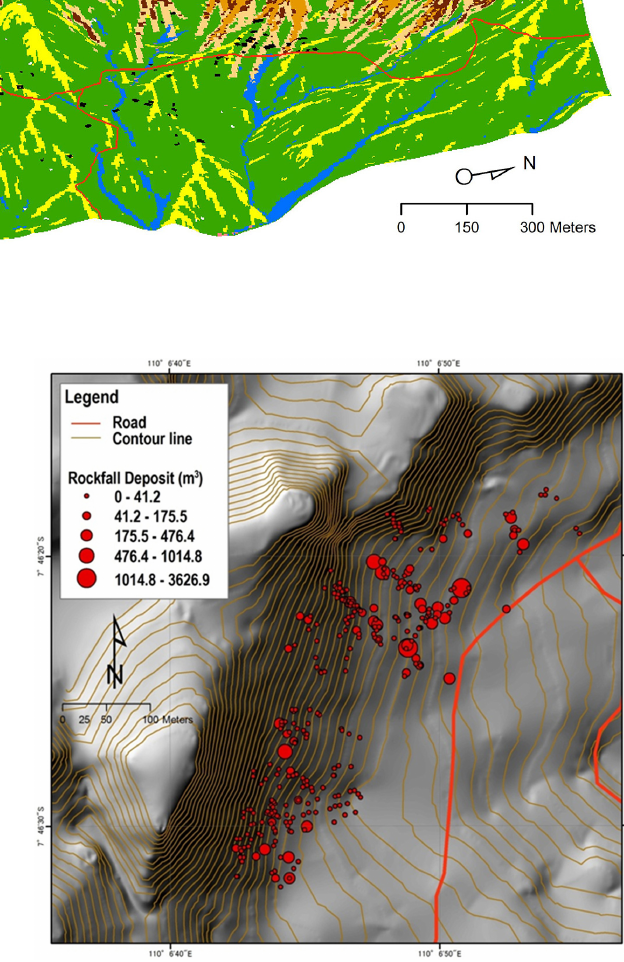
Figure 4. Distribution of rockfall boulders in Gunung Kelir ob- tained from geomorphological